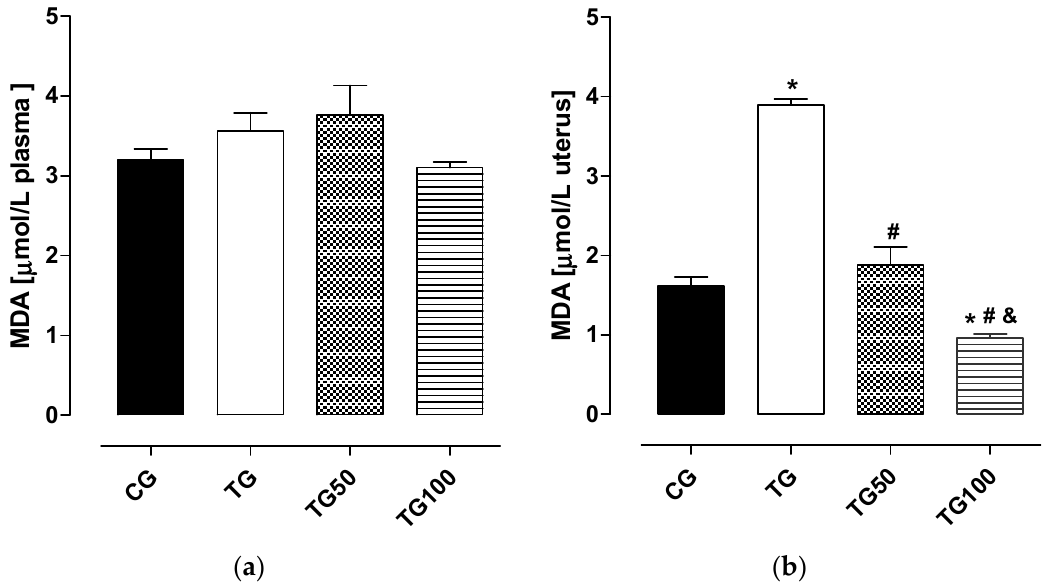
Figure 3. Effect of strength training and/or food supplementation with S. platensis on the concentration of MDA in the plasma ( a ) and in the uterus ( b ) of rats, in groups CG, TG, TG50 and TG100.The symbols and vertical bars represent the mean and the e.p.m., respectively ( n = 5). ANOVA one-way followed by Tukey’s post-test, * p < 0.05 (TG, TG50 and TG100 vs. CG); # p < 0.05 (TG50 and TG100 vs. TG); & p < 0.05 (TG100 and TG50 vs. TG). CG = control group; TG = trained group; TG50 = group trained and supplemented with algae at a dose of 50 mg/kg; TG100 = group trained and supplemented with algae at a dose of 100 mg/kg.